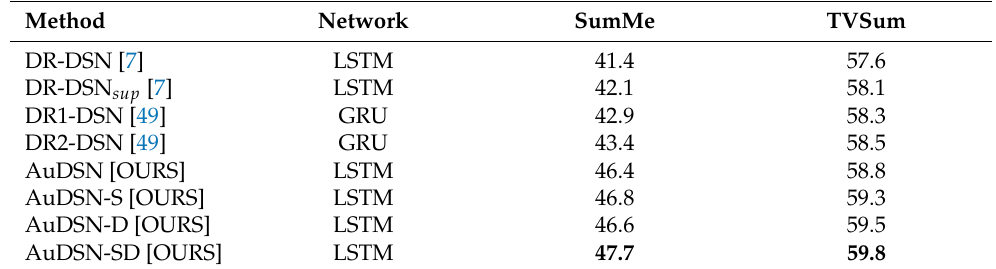
Table 3. Performance (F-scores (%)) of the proposed methods compared to other DRL-based